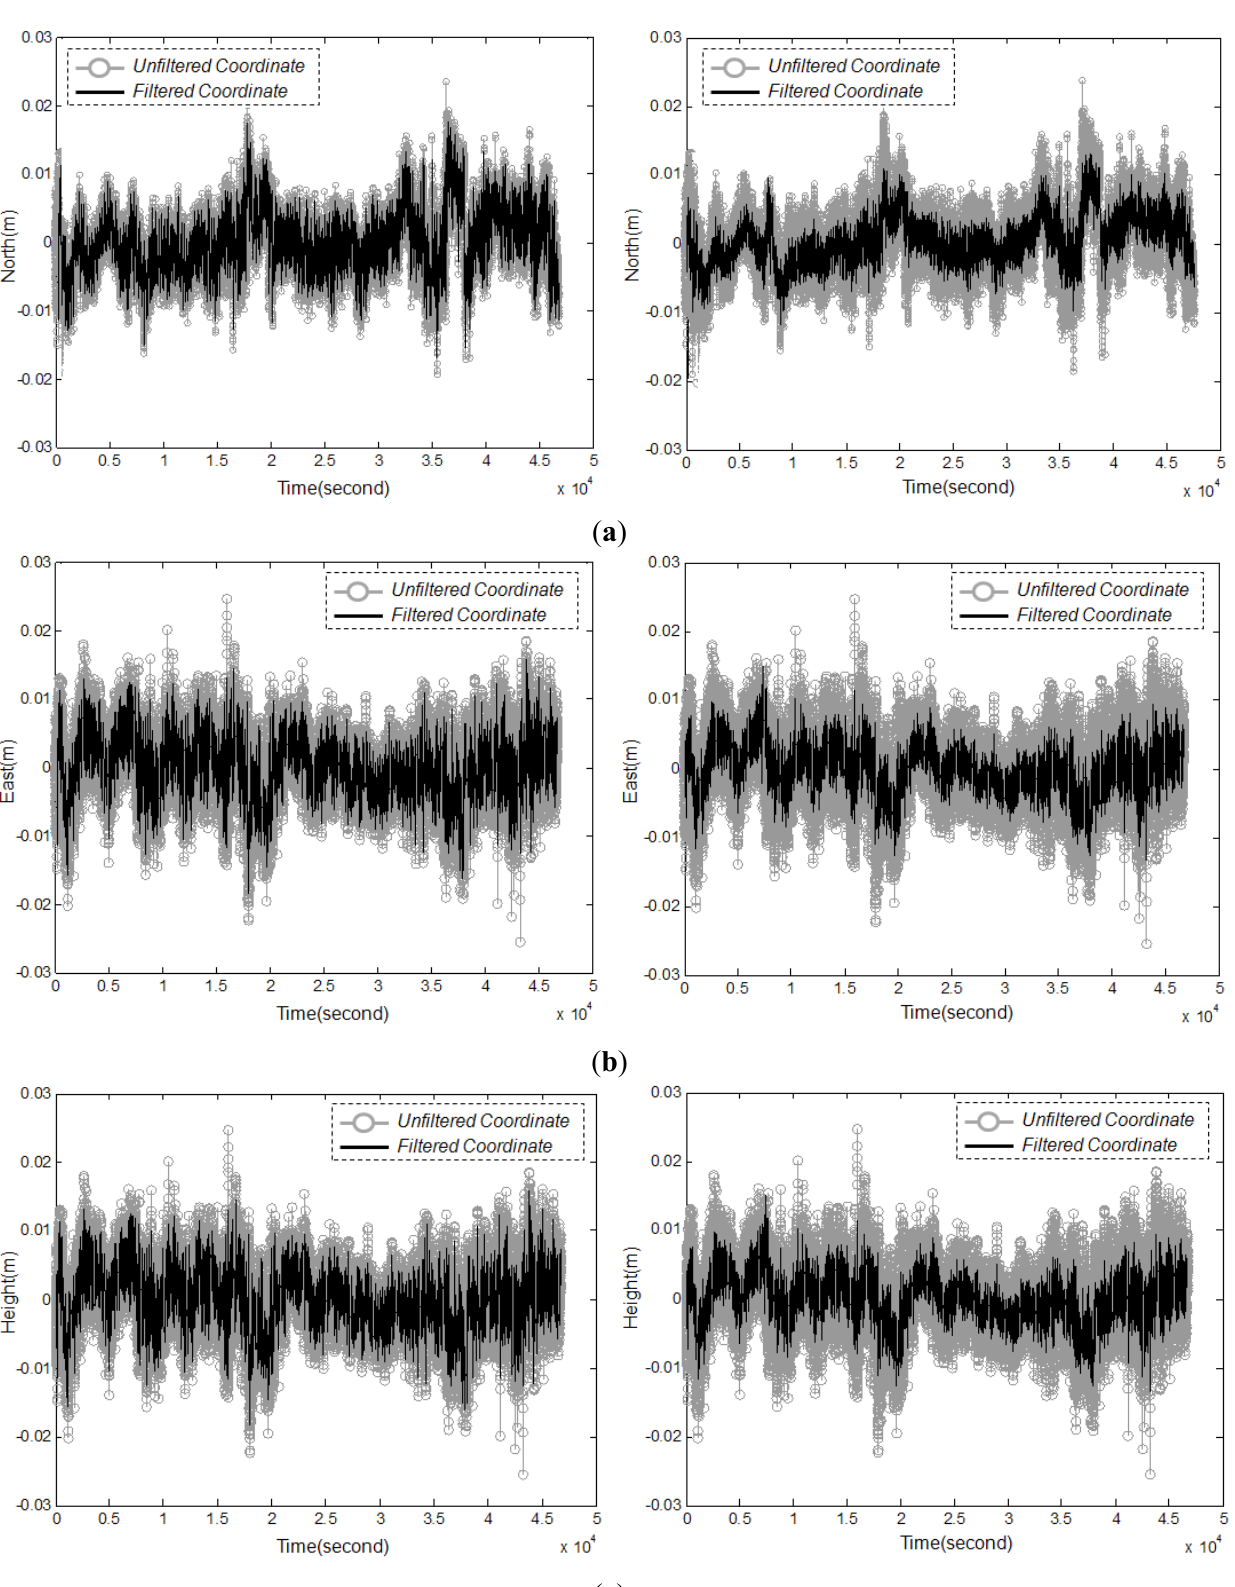
Figure 9. Filtering results of NRTK positioning for the 3D coordinates. ( a ) North coordinates from Case 1 (left) and Case 2 (right). ( b ) East coordinates from Case 1 (left) and Case 2 (right). ( c ) Ellipsoidal heights from Case 1 (left) and Case 2